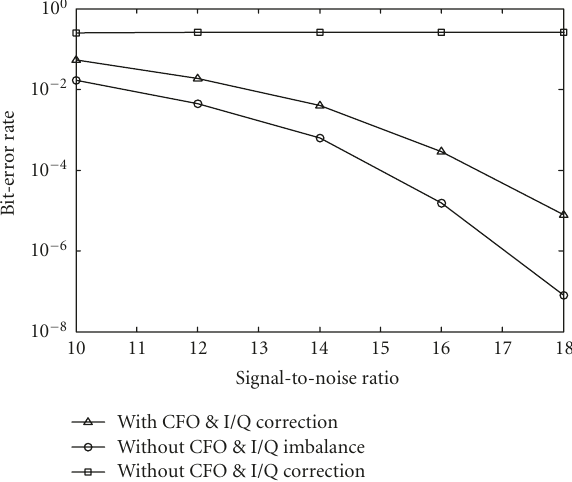
Figure 8: MSE of I/Q imbalance estimate versus number of short symbols used ( U = tgθ and V = 1 /g cos θ ).